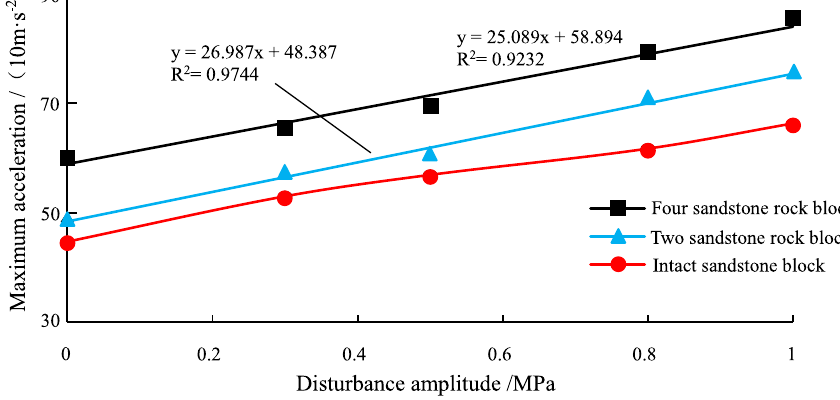
Fig. 10 Relationship between the maximum acceleration and the disturbance amplitude under different levels of horizontal impact